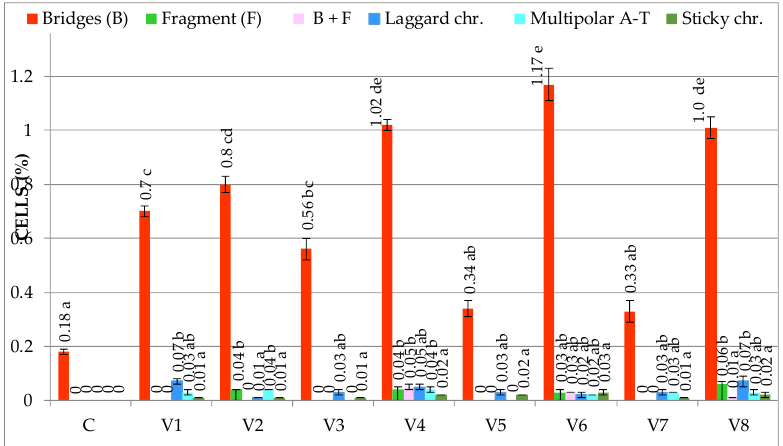
Figure 2. Frequency of genetic abnormalities in wheat root meristem metaphases induced by non-thermal plasma-activated water treatment. Bars are means of three replicates/experimental variant ± SD. The letters (a–c) show significant differences, p < 0.05.